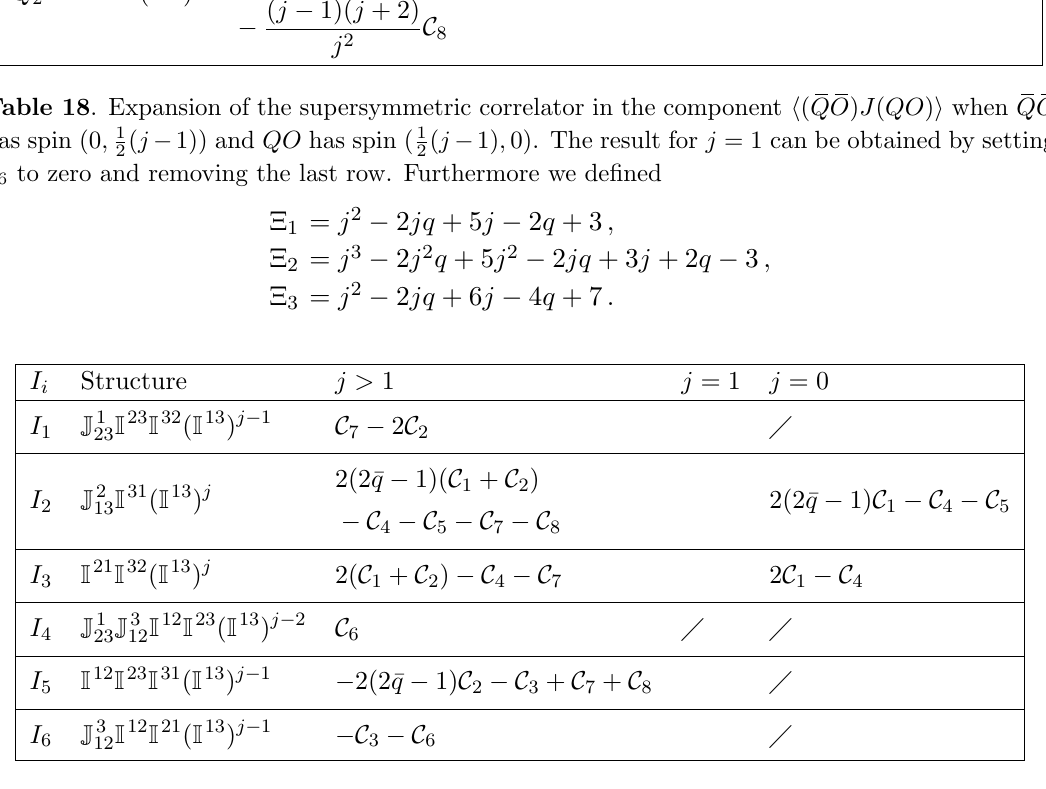
Table 19 . Expansion of the supersymmetric correlator in the component has spin ( 1 ; 1 j ). The unbarred entries in the j = 1 column can be obtained by setting 2 2